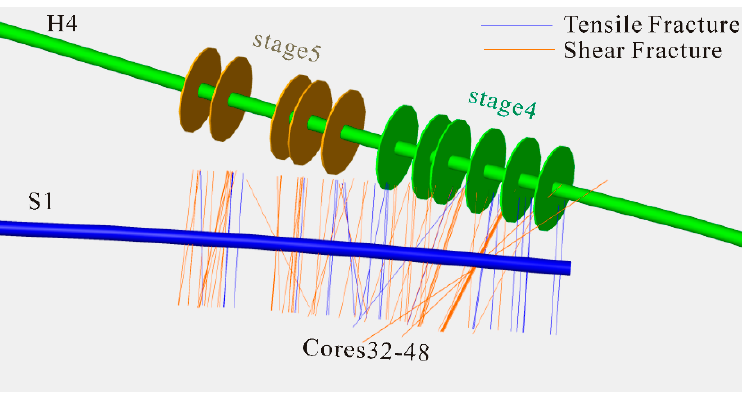
Figure 16. Side view of fractures in cores 32–48. The viewpoint is from the west.